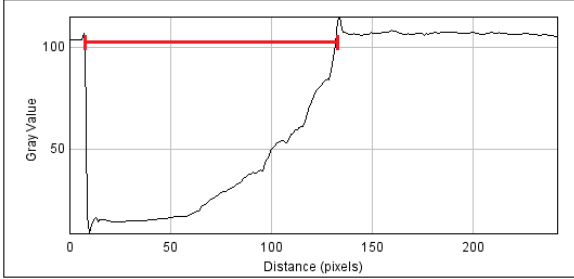
Fig. 5. Curve of the mean digital grey value along the yellow evaluative